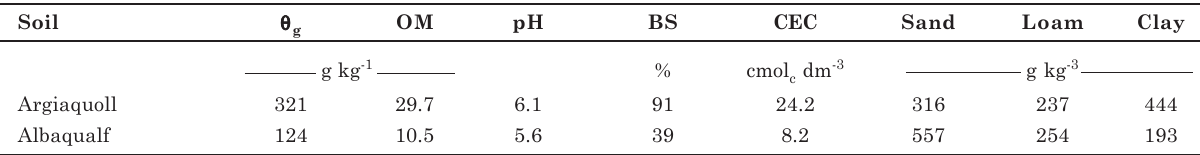
Table 1. Gravimetric soil moisture ( θθθθθ g ), soil organic matter (OM), pH, base saturation (BS), cation exchange capacity (CEC) and sand, loam and clay content of the two soil classes used in the